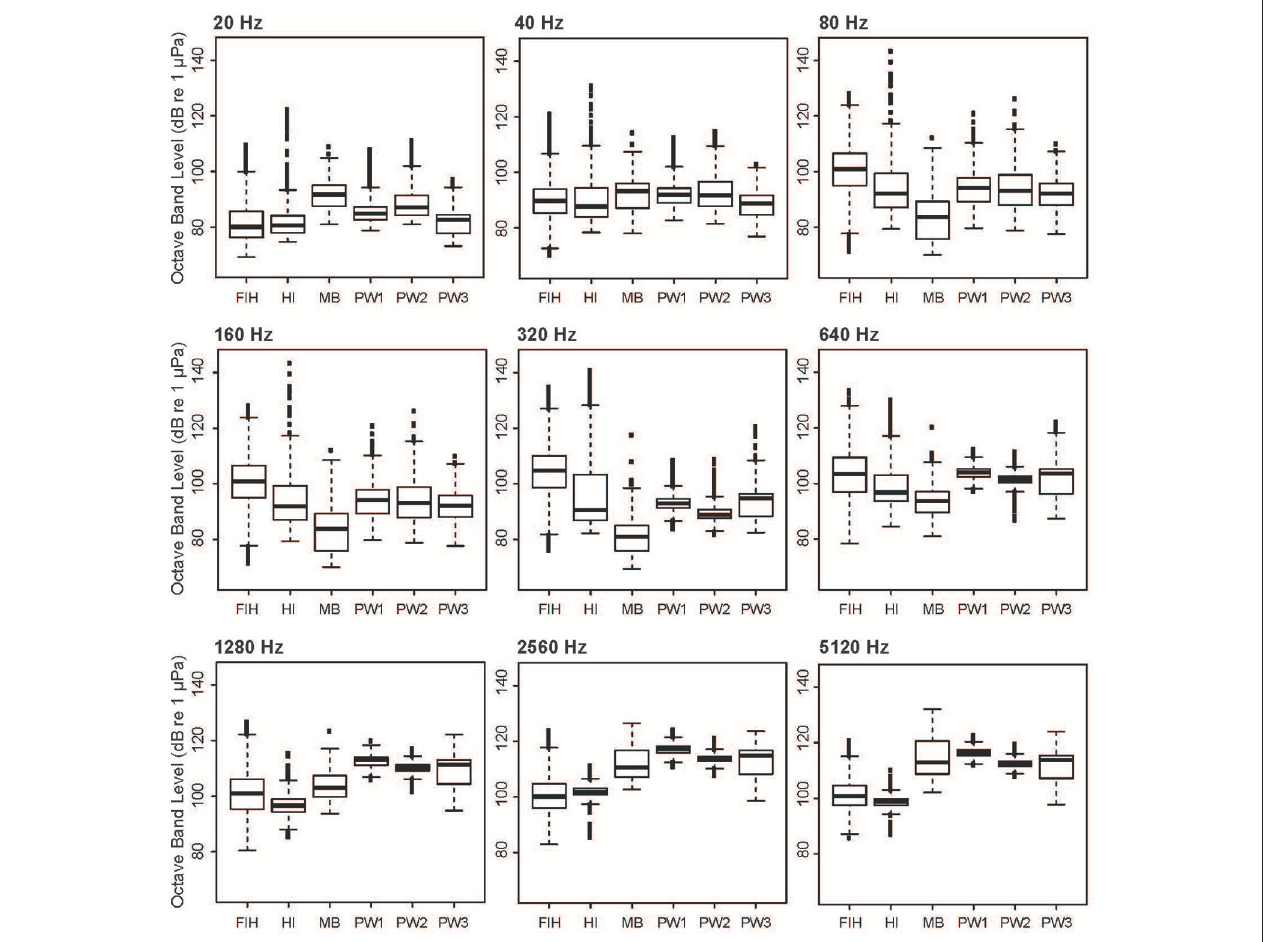
FIGURE 7 | Variation in selected octave-band levels between the four sites considered in the spatial analysis: Fremantle Inner Harbor (FIH); Heirisson Island (HI); Matilda Bay (MB); and Perth Waters (PW1-3).